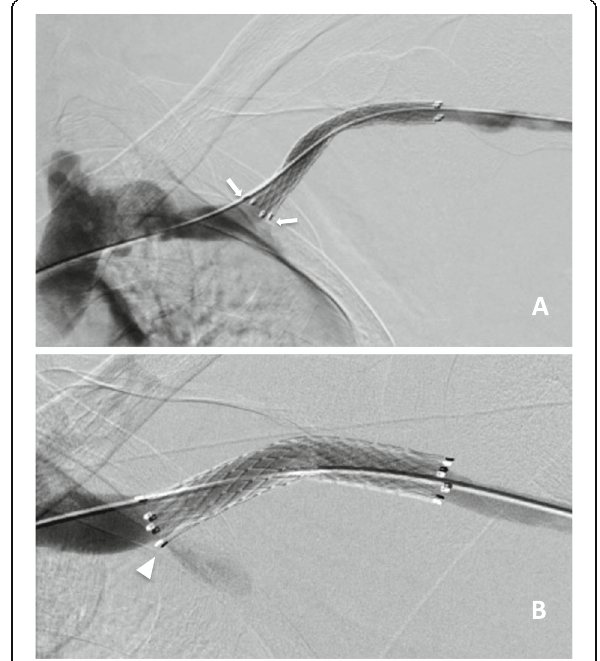
Fig. 1 Cephalic arch venograms. a Immediately after deployment of the 8×60mm Fluency stent graft showing precise positioning (arrows) of the central end of stent flush with the superior wall of the subclavian vein. b 5months after stent deployment, the inferior edge of the central end of the stent is back-walling the inferior wall of the subclavian vein (arrowhead) resulting in jailing of the axillary vein